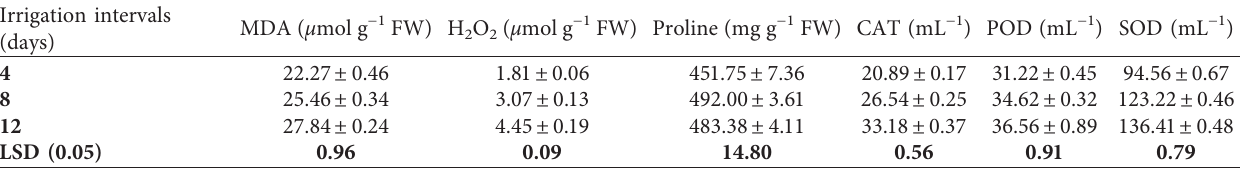
Table 3: Impact of irrigation intervals on some biochemical traits of mung bean crops growing under water stress conditions (Mean ± SE). Irrigation intervals (days)